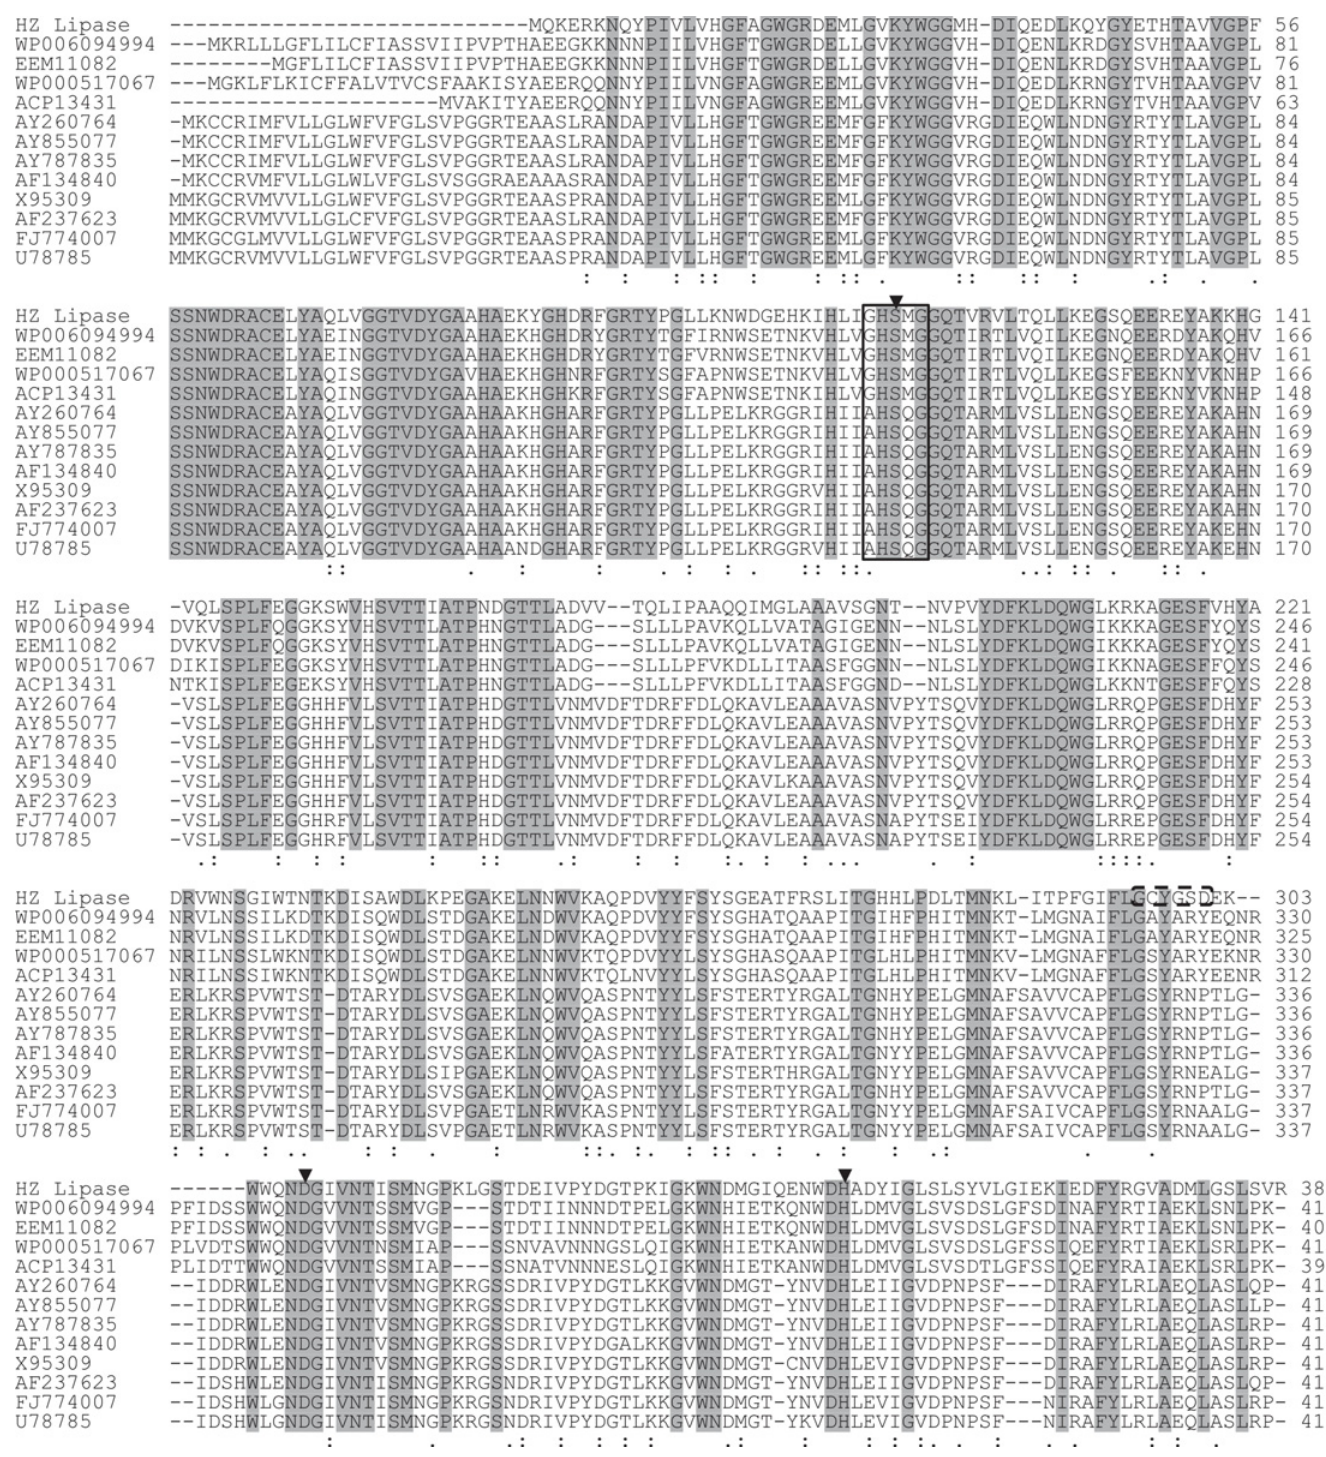
Fig 1. Multiple amino acid sequence alignment of HZ lipase and other thermostable lipases from subfamily I.5. The accession numbers of the aligned sequences are for the following organisms: WP_006094994, Bacillus pseudomycoides DSM 12442; EEM11082, Bacillus mycoides Rock3-17; WP_000517067, Bacillus cereus B4264; ACP13431, Bacillus anthracis CDC684; AY260764, Geobacillus zalihae strain T1; AY855077, Bacillus sp. L2; AY787835, Bacillus sp. 42; AF134840, Bacillus thermoleovorans ; X95309, Bacillus thermocatenulatus; AF237623, Bacillus stearothermophilus P1; FJ774007, Geobacillus sp. NTU 03; U78785, Bacillus stearothermophilus L1 . Fully conserved residues are indicated by a dark gray background . Open box is